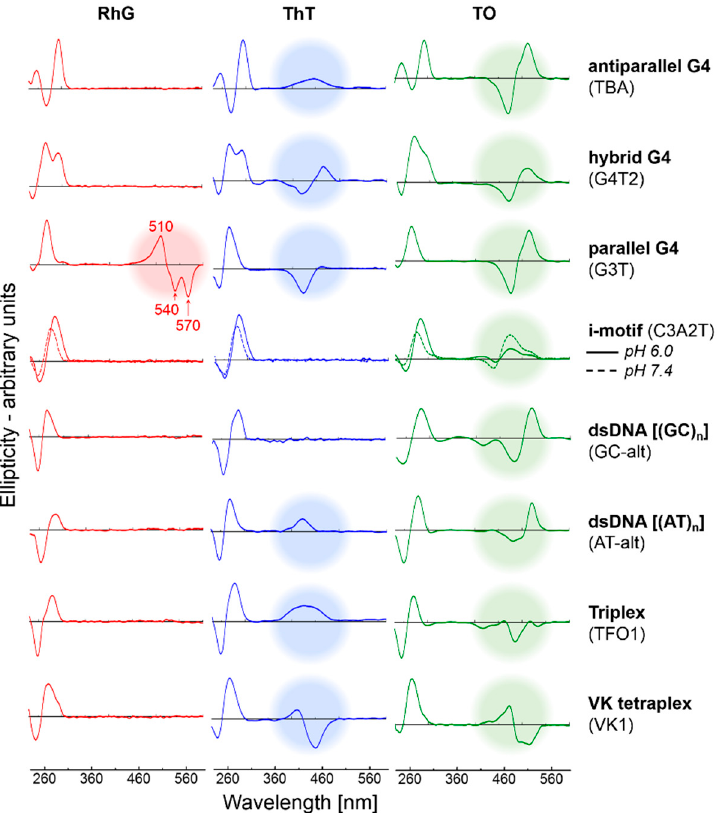
Figure 2. Absorption spectra of 130 µM ligands used in this study in a 25 mM mRB buffer, pH 7.0.